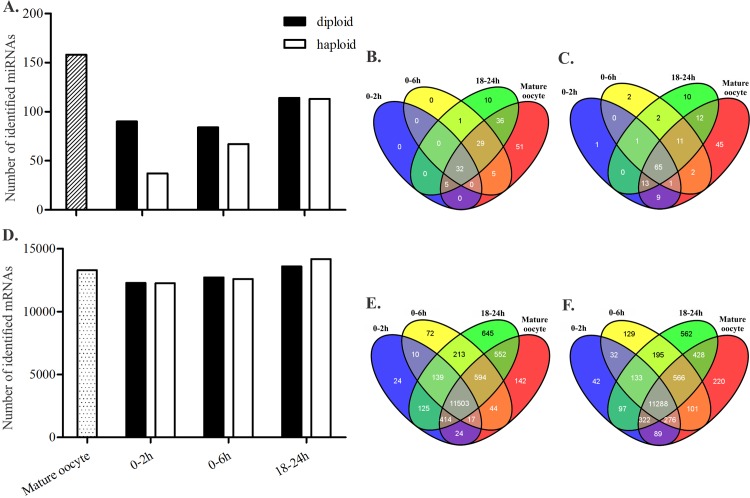
Total number of identified miRNAs and mRNAs in each library of haploid and diploid embryos, and mature oocytes of Apis mellifera.The total number of miRNAs (A) and mRNAs (D) identified in each library. Venn diagrams show the number of miRNAs (B and C) and mRNAs (E and F) shared or exclusively expressed in each analyzed developmental stage of haploid (B and E) and diploid (C and F) embryos.